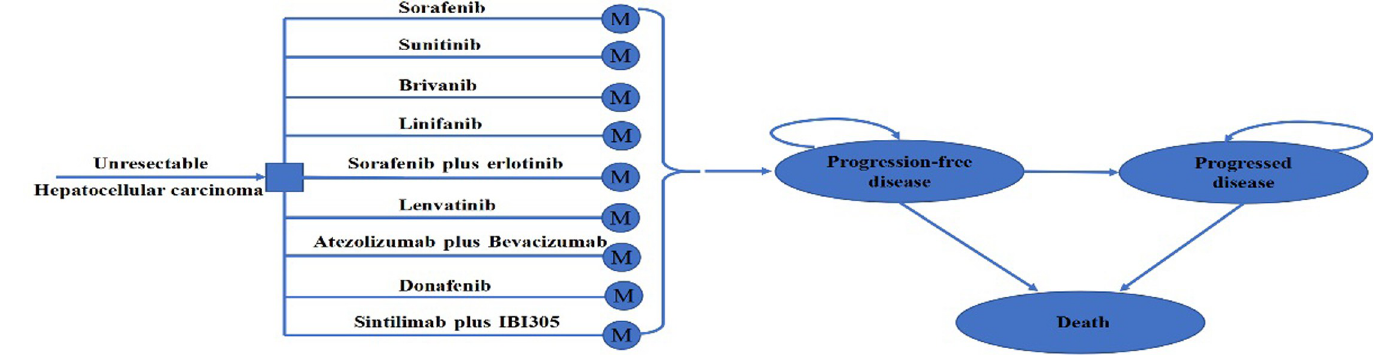
Fig 1. Model structure of a Markov model combining the decision tree. M, Markov.